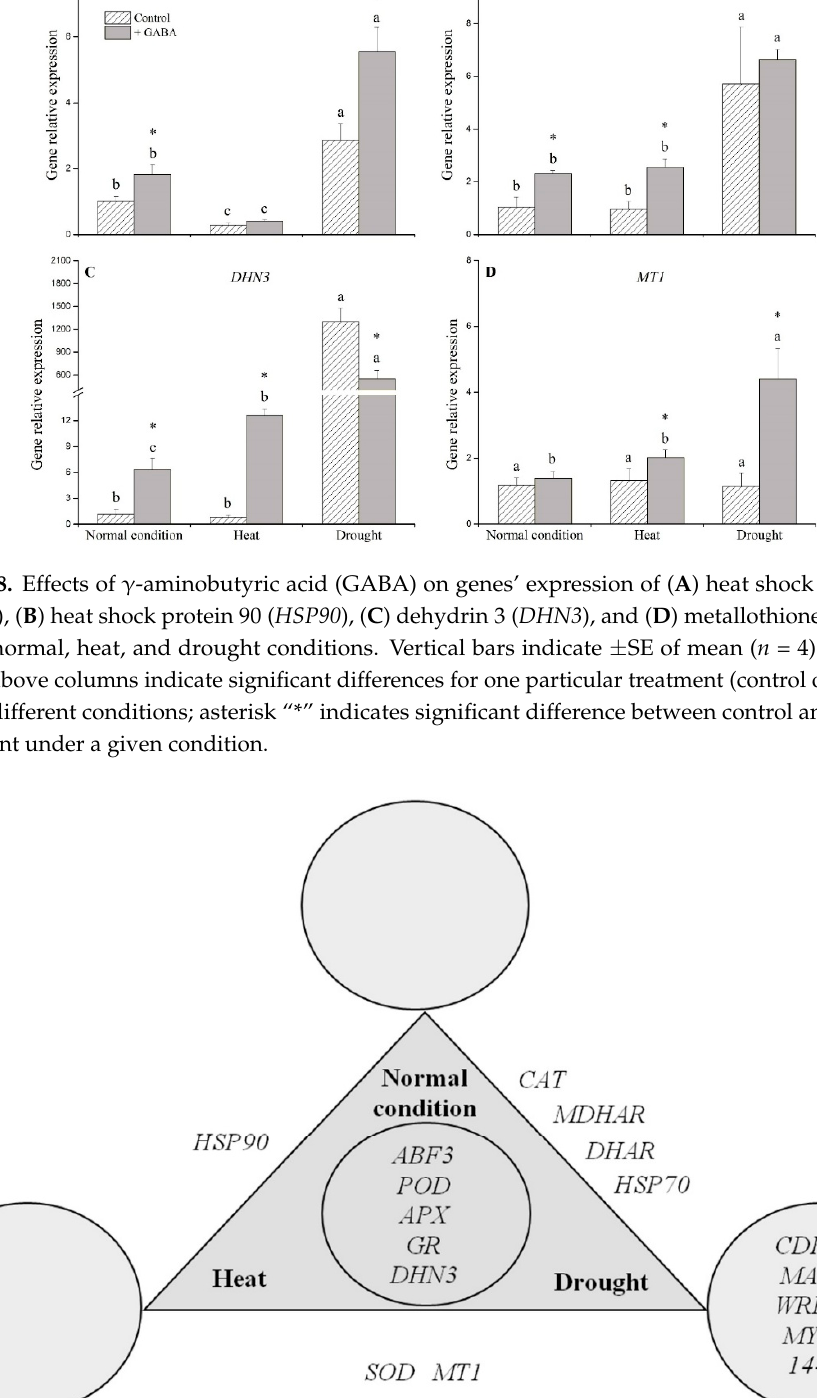
Figure 9. Differential expression of genes regulated by exogenous application of γ -aminobutyric acid (GABA) under different conditions.